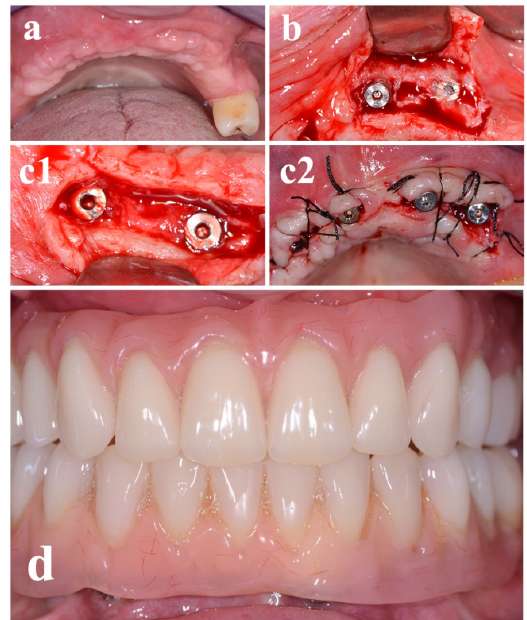
Figure 5. CBCT scans were done after 9 months to define implant placement width and length, on (a) axial and (b1,b2) cross-sectional images.